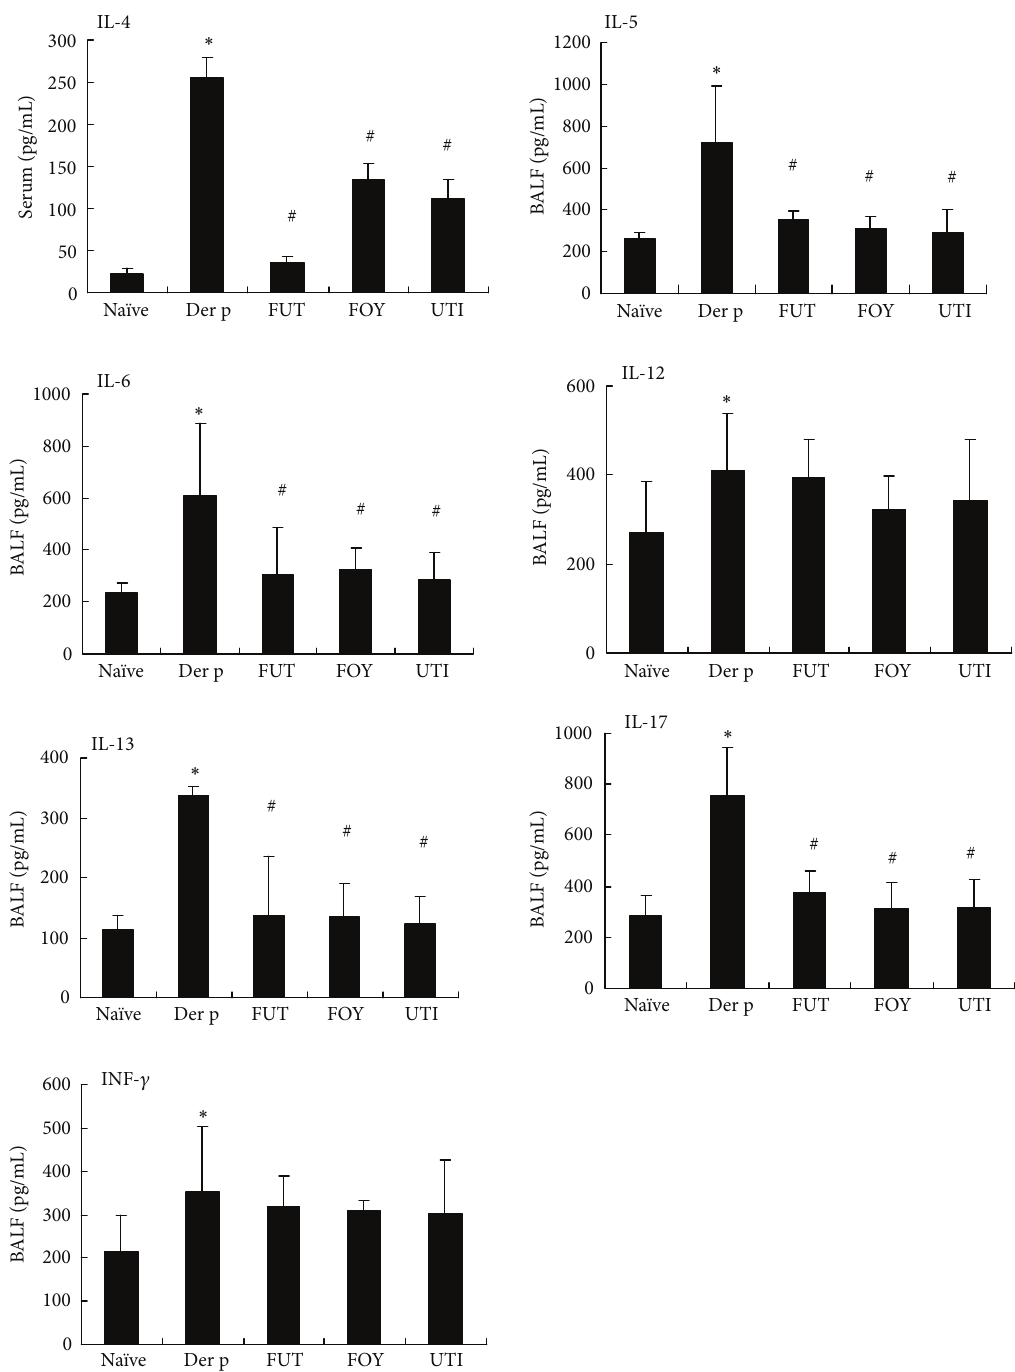
Figure 5: Effects of protease inhibitors on IL-5, IL-6, IL-13, and IL-17 levels in BALF and IL-4 levels in serum. Results are expressed as means ± SDs for 6 mice/group. ∗ 𝑃 < 0.05 versus na¨ıve group; # 𝑃 < 0.05 between Der p-treated